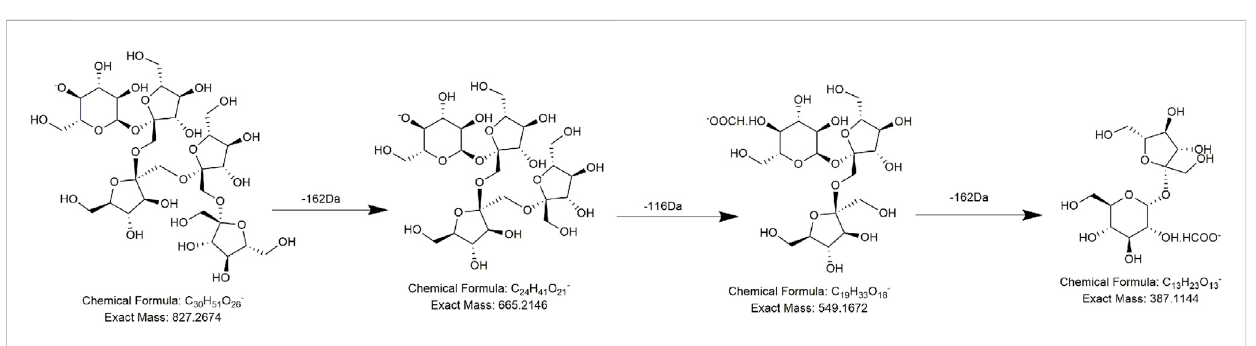
FIGURE 11 Proposed fragmentation pathways of G4